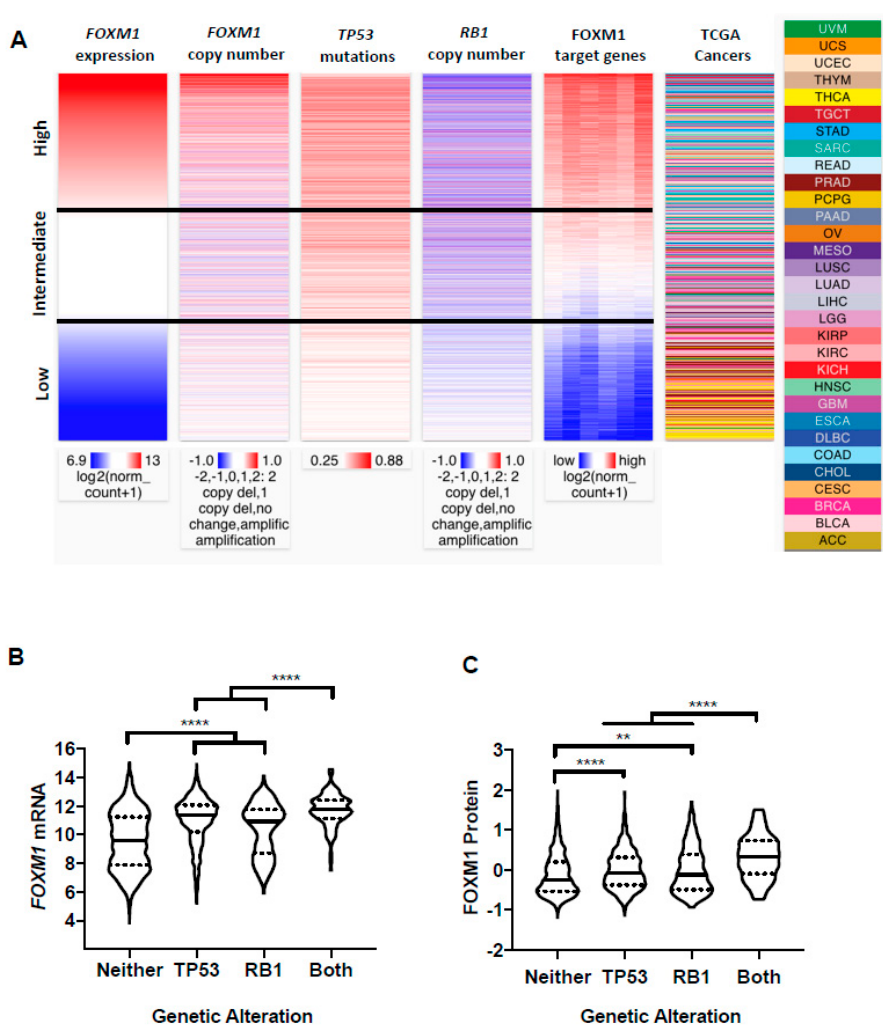
Figure 4. FOXM1 expression in TCGA cancer types by p53/Rb status. ( A ) Comparison of FOXM1 mRNA expression, FOXM1 copy number, TP53 somatic mutations, RB1 copy number, and FOXM1 target genes among all TCGA primary tumors with overlapping genomics data. Data were retrieved from UCSC Xena. FOXM1 target genes included AURKB , CCNA2 , CCNB1 , CCNB2 and CENPA . ( B , C ) FOXM1 expression in tumors with T53 somatic mutations and RB1 copy number loss. ( B ) FOXM1 mRNA expression (RNA-seq RSEM, log2(norm count +1)) in tumors with T53 somatic mutations ( n = 1288), RB1 copy number loss or somatic mutation ( n = 190), both alterations ( n = 128) or neither alteration ( n = 3362). ( C ) FOXM1 protein expression (RPPA pan-can normalized) in tumors with T53 somatic mutations ( n = 1288), RB1 copy number loss or somatic mutation ( n = 190), both alterations ( n = 128), or neither alteration ( n = 3362). Mann-Whitney test p values are shown. p value designations: **** < 0.0001, ** < 0.01,